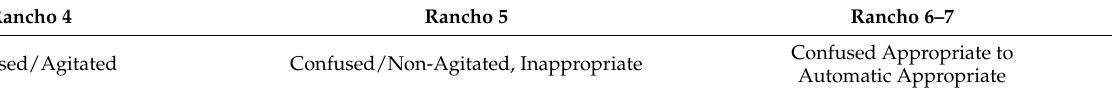
Table 2. Data adapted from Somner JL, Witkiewicz PM. The therapeutic challenges of dual diagnosis: TBI/SCI. Brain Inj 2004; 18